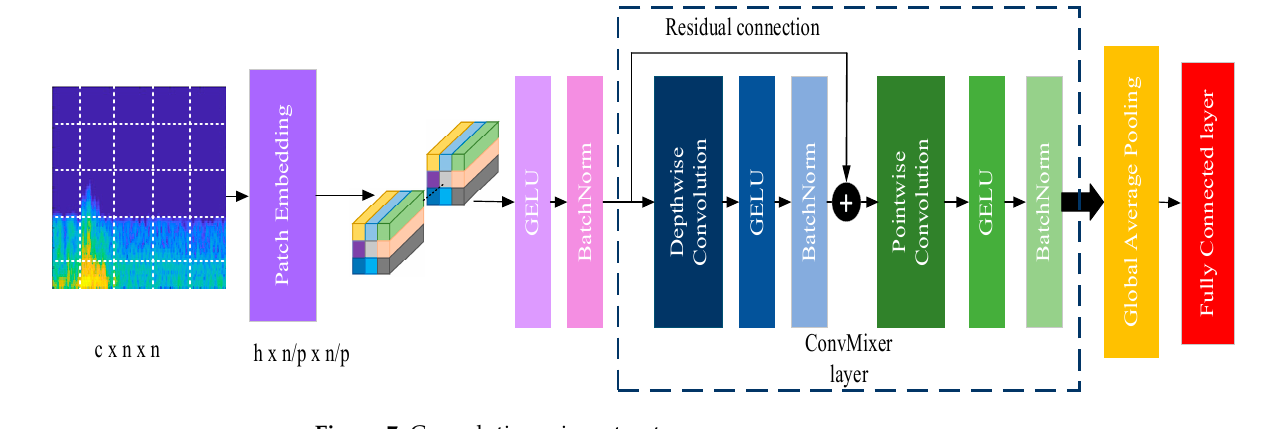
Figure 7. Convolution mixer structure.